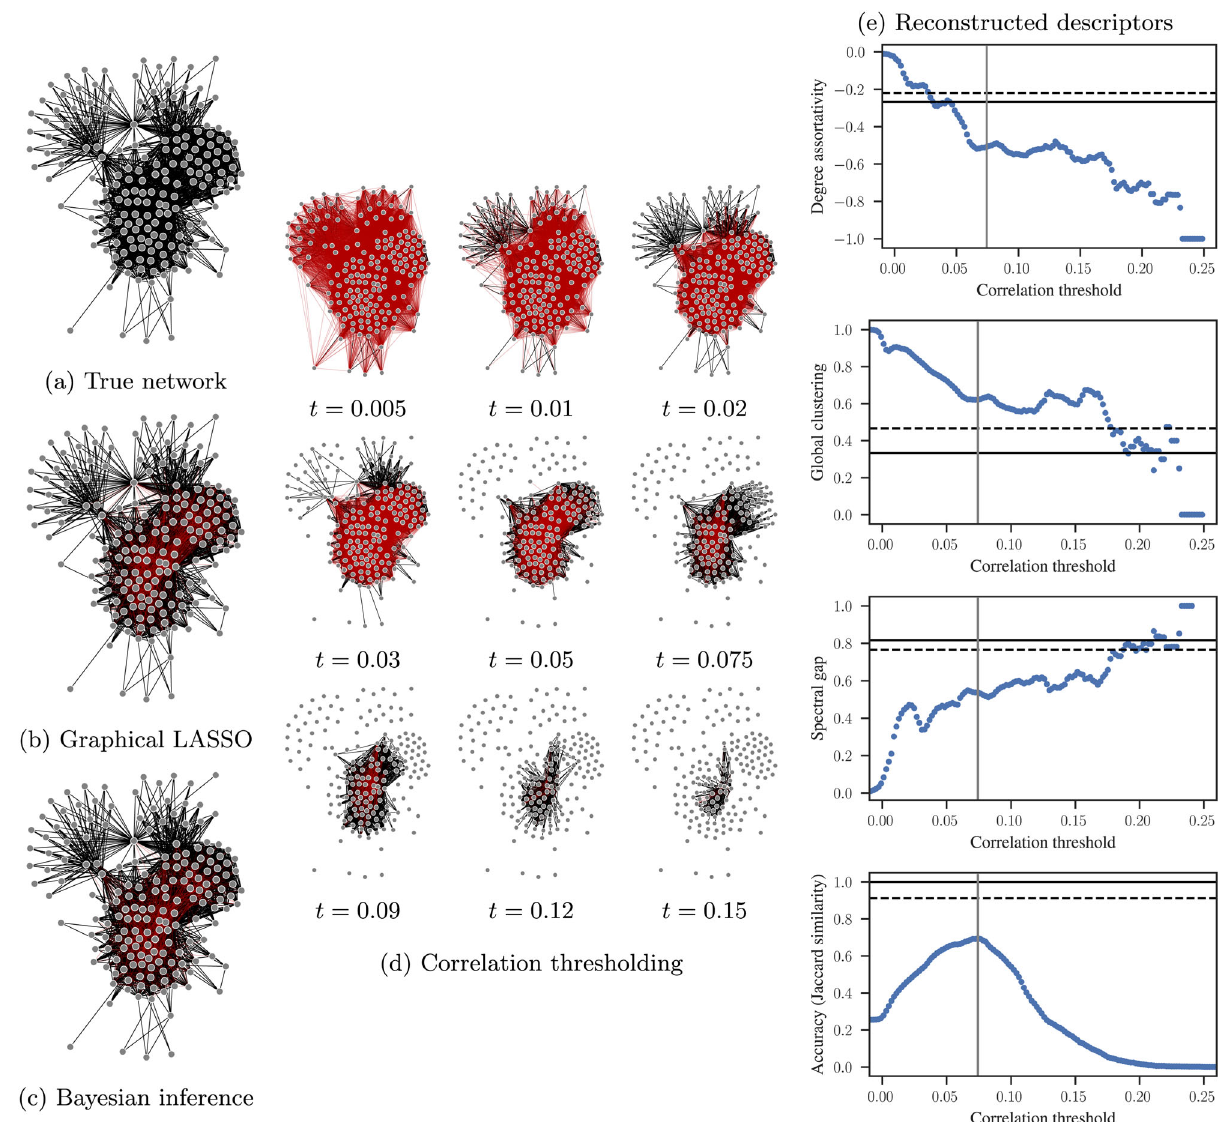
Fig. 2 | Network reconstruction in action. Reconstruction of an empirical food web (upper left), from M =10 5 samples of the Ising model at critical temperature. Left panels: a The true original network, compared with a reconstructed network obtained by inferring a sparse precision (inverse covariance) matrix using the graphical LASSO ( b ). Edges that do not exist in the true network are colored red. The graphical LASSO assumes the data is drawn from a multivariate Gaussian, which is clearly a misspeci fi cation. However, even this misspeci fi ed model per- forms better than naive correlation thresholding. The result obtained with the Bayesian method of ref. 68, which matches the data-generating process and